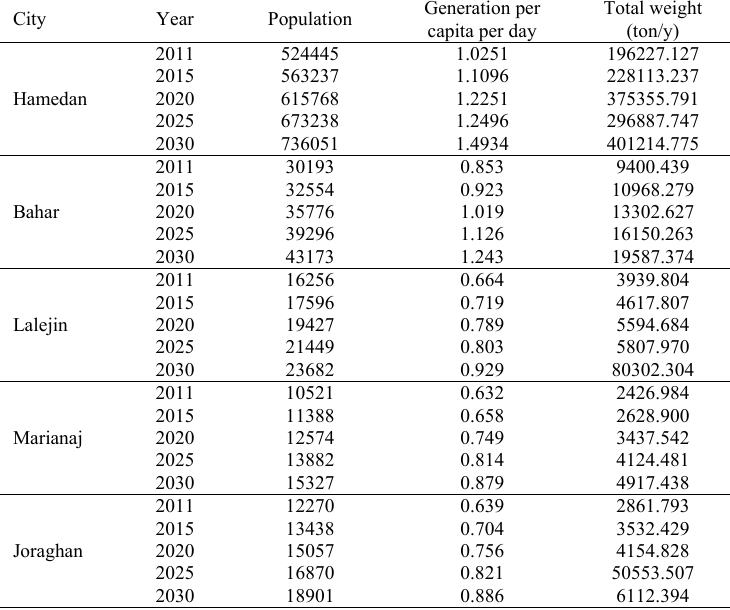
Table 2: Rate of solid wastes generation in the study area during 2011 to 2030